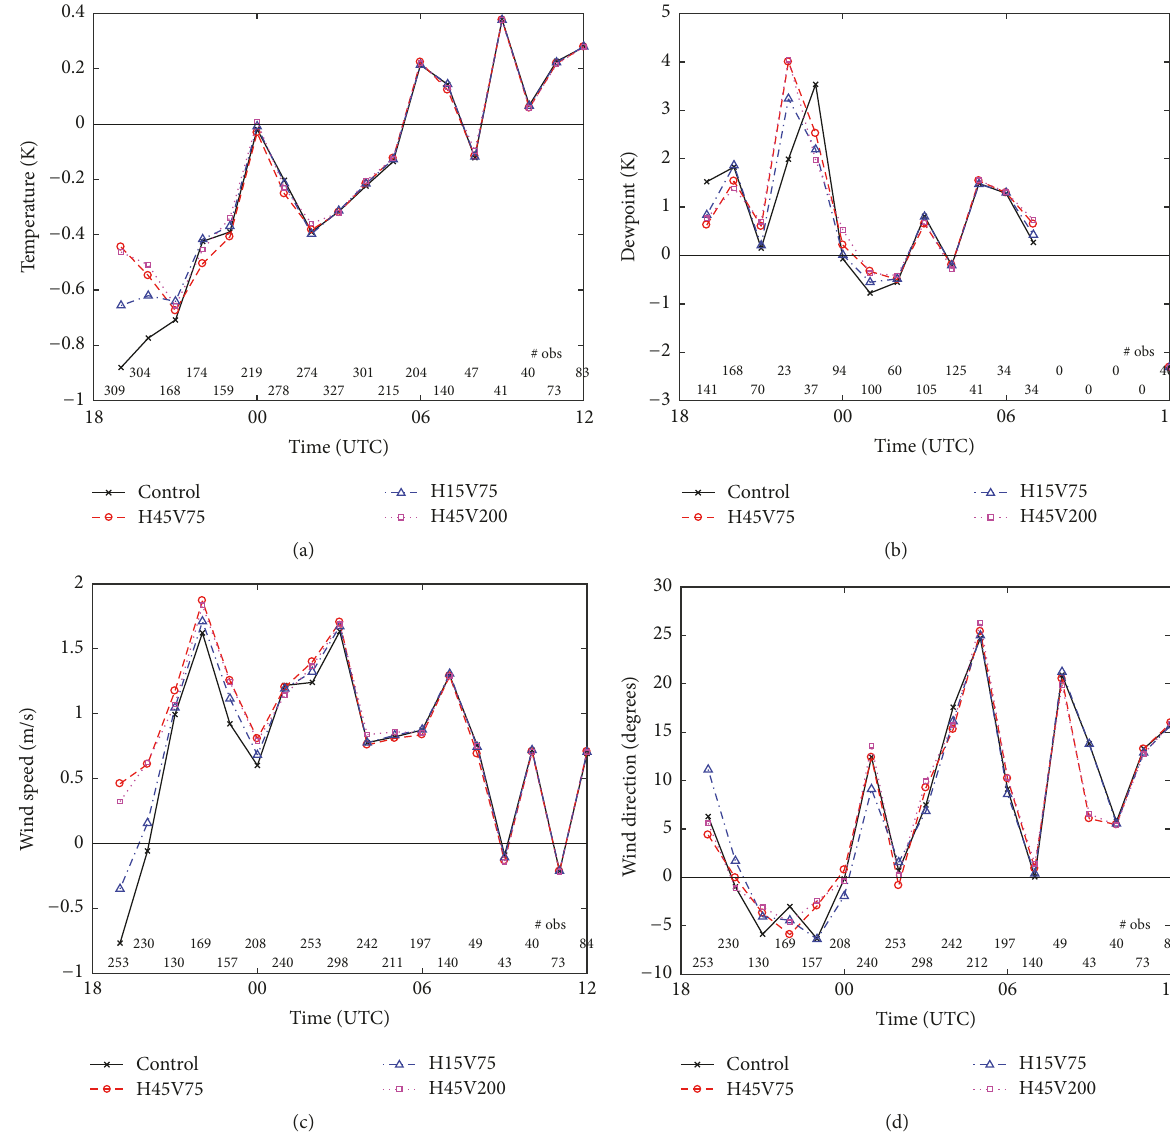
Figure 7: Time series of the ME for each experiment for the 1–18 h forecast (19–12 UTC) for the 0–1000 m AGL layer for (a) temperature, (b) dewpoint, (c) wind speed, and (d) wind direction as compared to above-surface observations and calculated over observations from all five case days. The number of observations used to create the verification at each time is noted just above the horizontal axis at the bottom of the